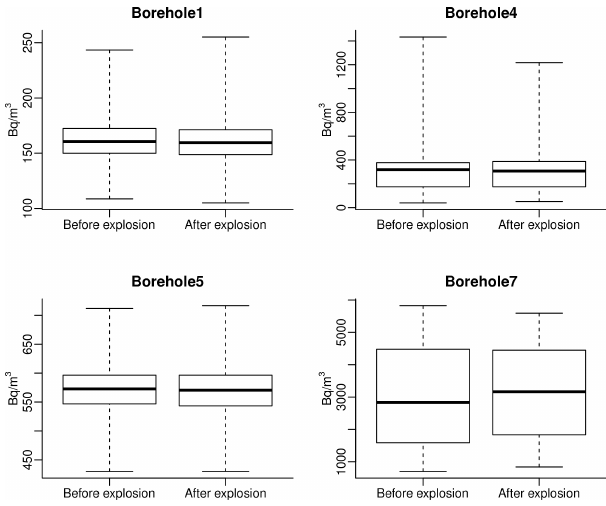
Fig. 5. Boxplots of radon concentration values 24h before and after the explosion events marked in Figs. 3 and